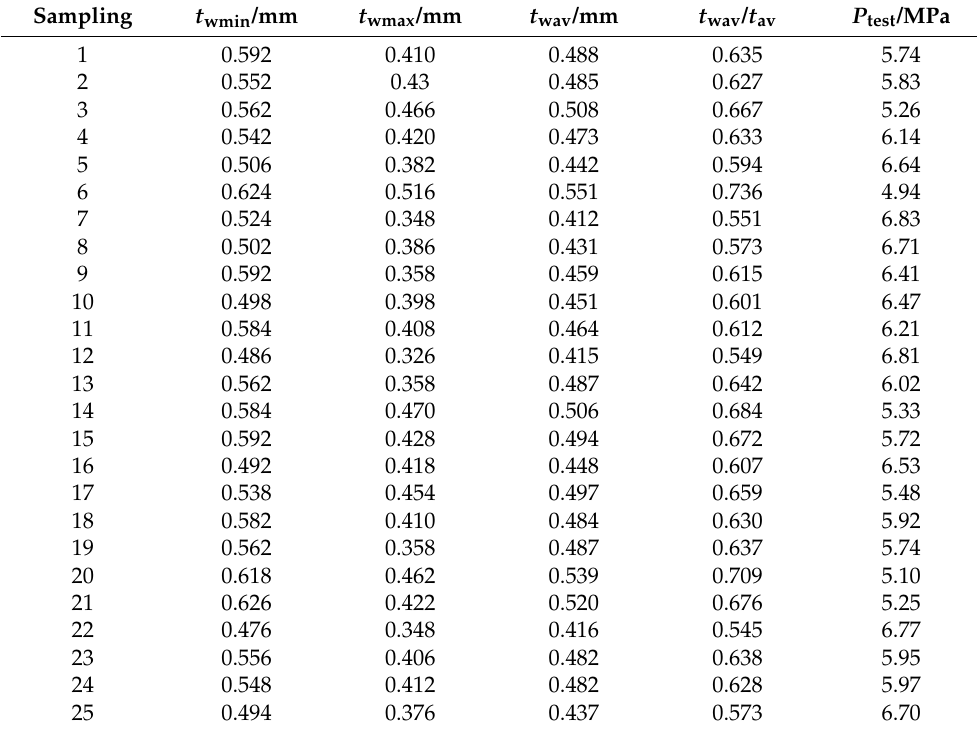
Table 2. Results of thickness measurement in the welding